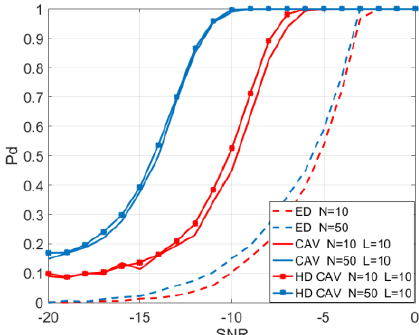
Figure 9. The ROC curves for HD CAF (without uncertainty of spectral density of noise power estimation